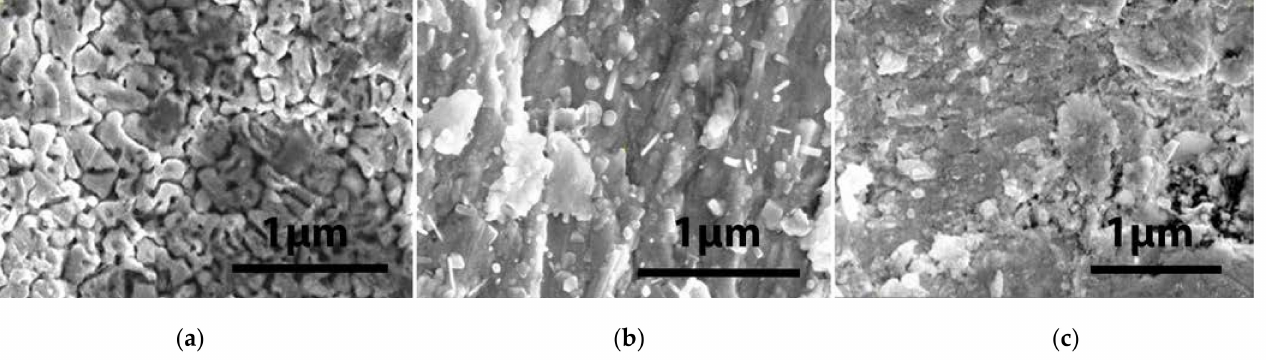
Figure 5. High-magnification images of W surface after the second session of 10 min irradiation at 6 MeV: ( a ) W-Ti ( × 50,000); ( b ) W-Cu ( × 50,000) and ( c ) W-V ( ×